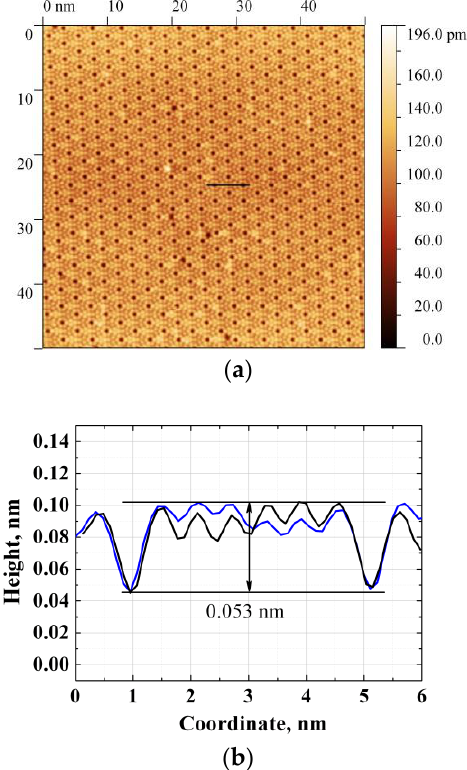
Figure 4. Comparison of the profiles at different voltages on the tunnel gap. ( a ) Image taken at +2 V, 0.025 nA, 50 × 750 nm 2 . ( b ) Profile comparison: black curve profile at +2.0 V and blue curve at +1.5 V.